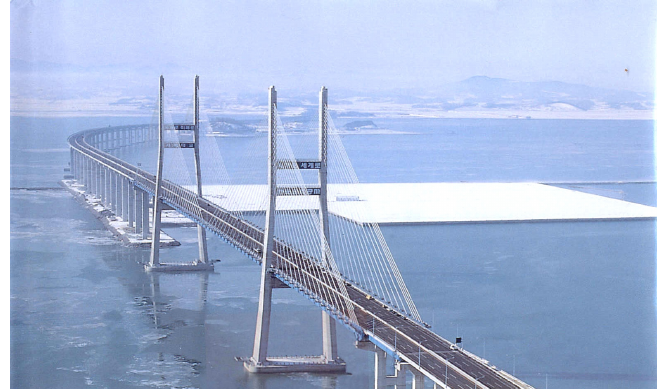
Figure 2. Seohae Bridge.